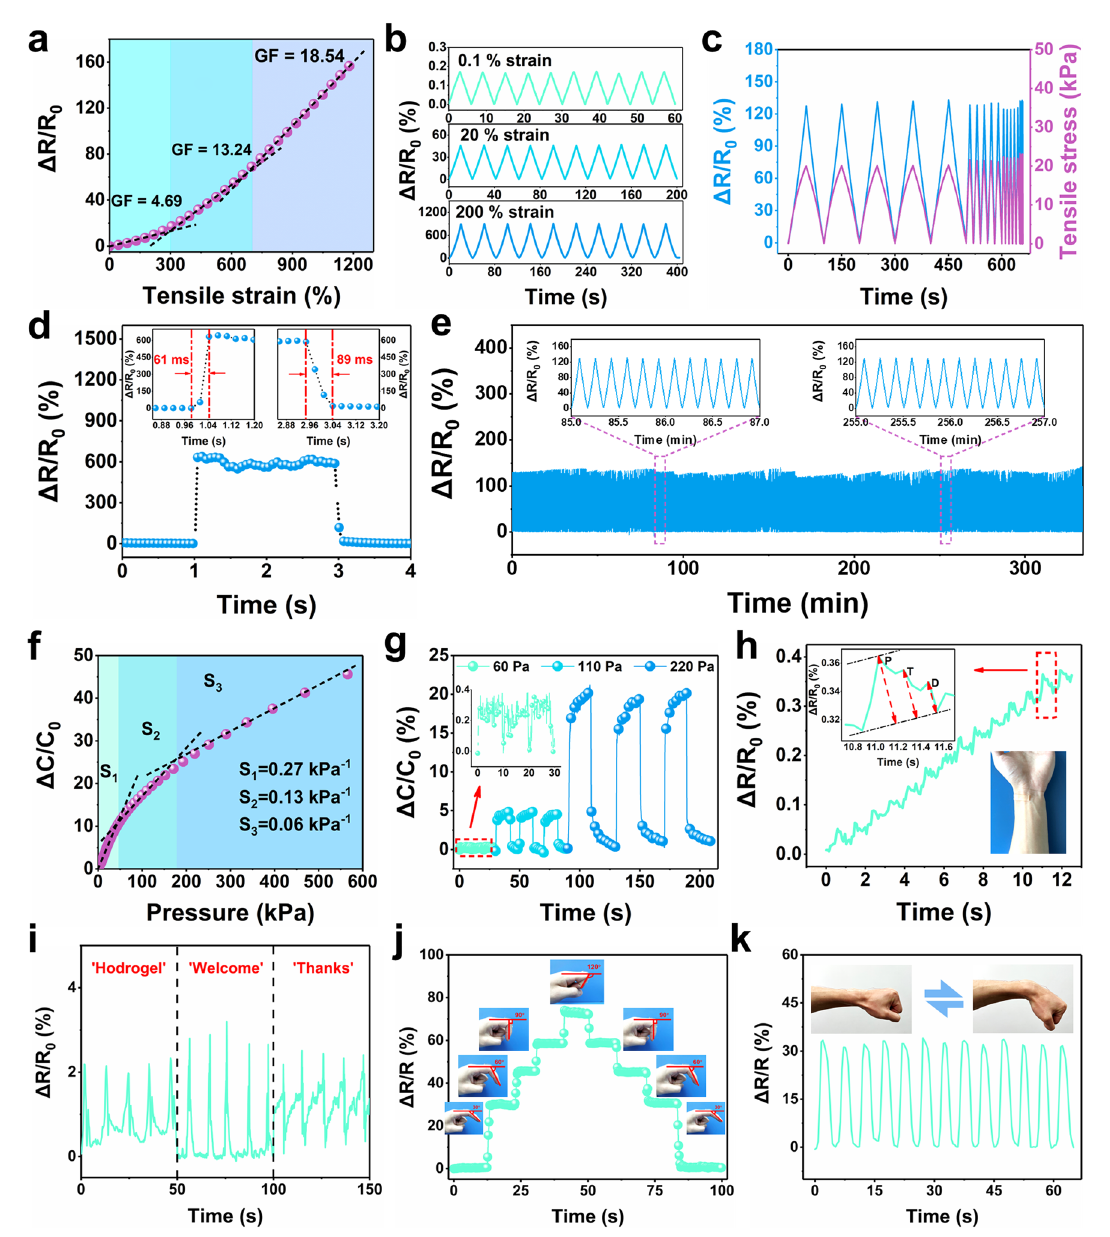
Fig. 5 a Relative resistance changes of C 11 T 4 A 20 sensor as a function of tensile strain. b Relative resistance changes of C 11 T 4 A 20 sensor under different tensile strains during 10 successive cycles. c Relative resistance changes under tensile stress with various frequencies. d Response time and release time of C 11 T 4 A 20 sensor. e Relative resistance changes under repeated loading–unloading processes with a strain of 50% for 2000 cycles, showing the durability of the sensor. f Relative capacitance changes of C 11 T 4 A 15 sensor versus the applied pressure. g Relative capaci- tance changes of C 11 T 4 A 15 sensor under different compressive stress. h Relative resistance changes of C 11 T 4 A 20 strain sensor monitoring wrist pulse. Inset shows the photograph of a sensor attached to the wrist. i Phonation when the wearer spoke “Hydrogel,” “Welcome,” and “Thanks.” j Relative resistance changes with bending of finger. k Repeated bending/unbending movements of signal monitoring of the